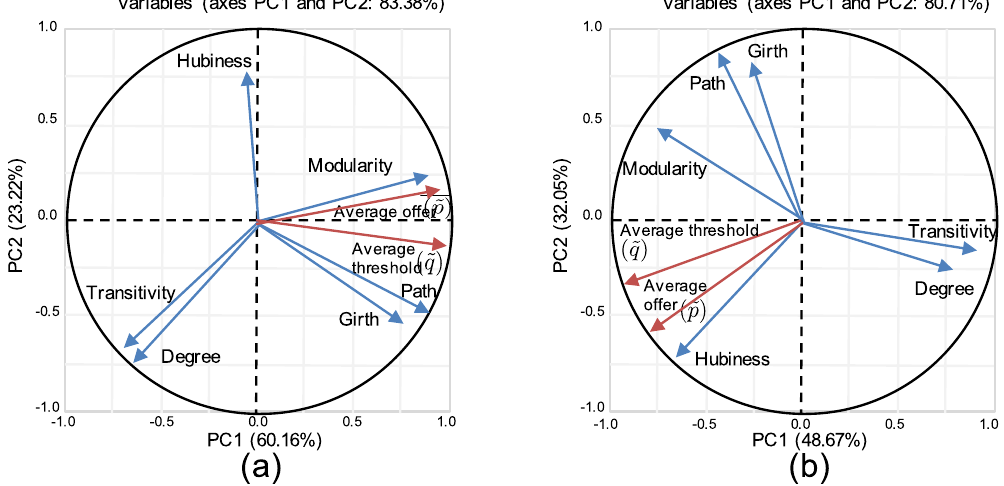
Figure 3. Effects of the initialization and the game score. ( a ) Results of PCA on simulation data when agents’ strategies are initialized from uniform distribution U(0, 0.5), ( b ) results of PCA when total accumulated payoff is used the game score (without normalizing on the agent’s